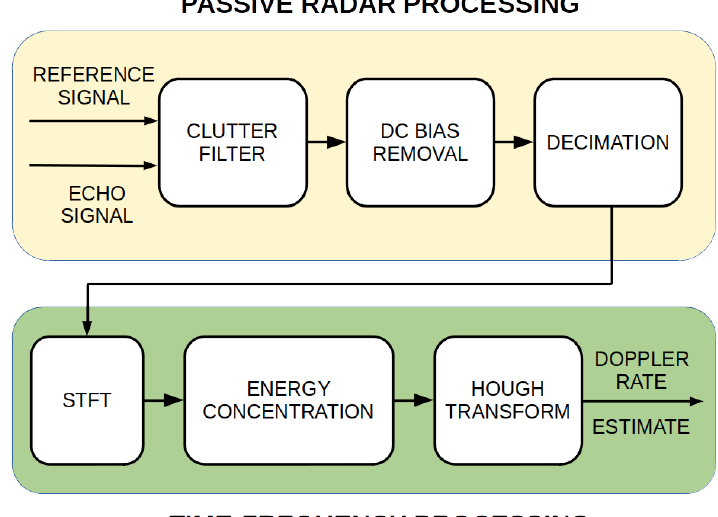
Figure 5. Digital multichannel signal recorder.